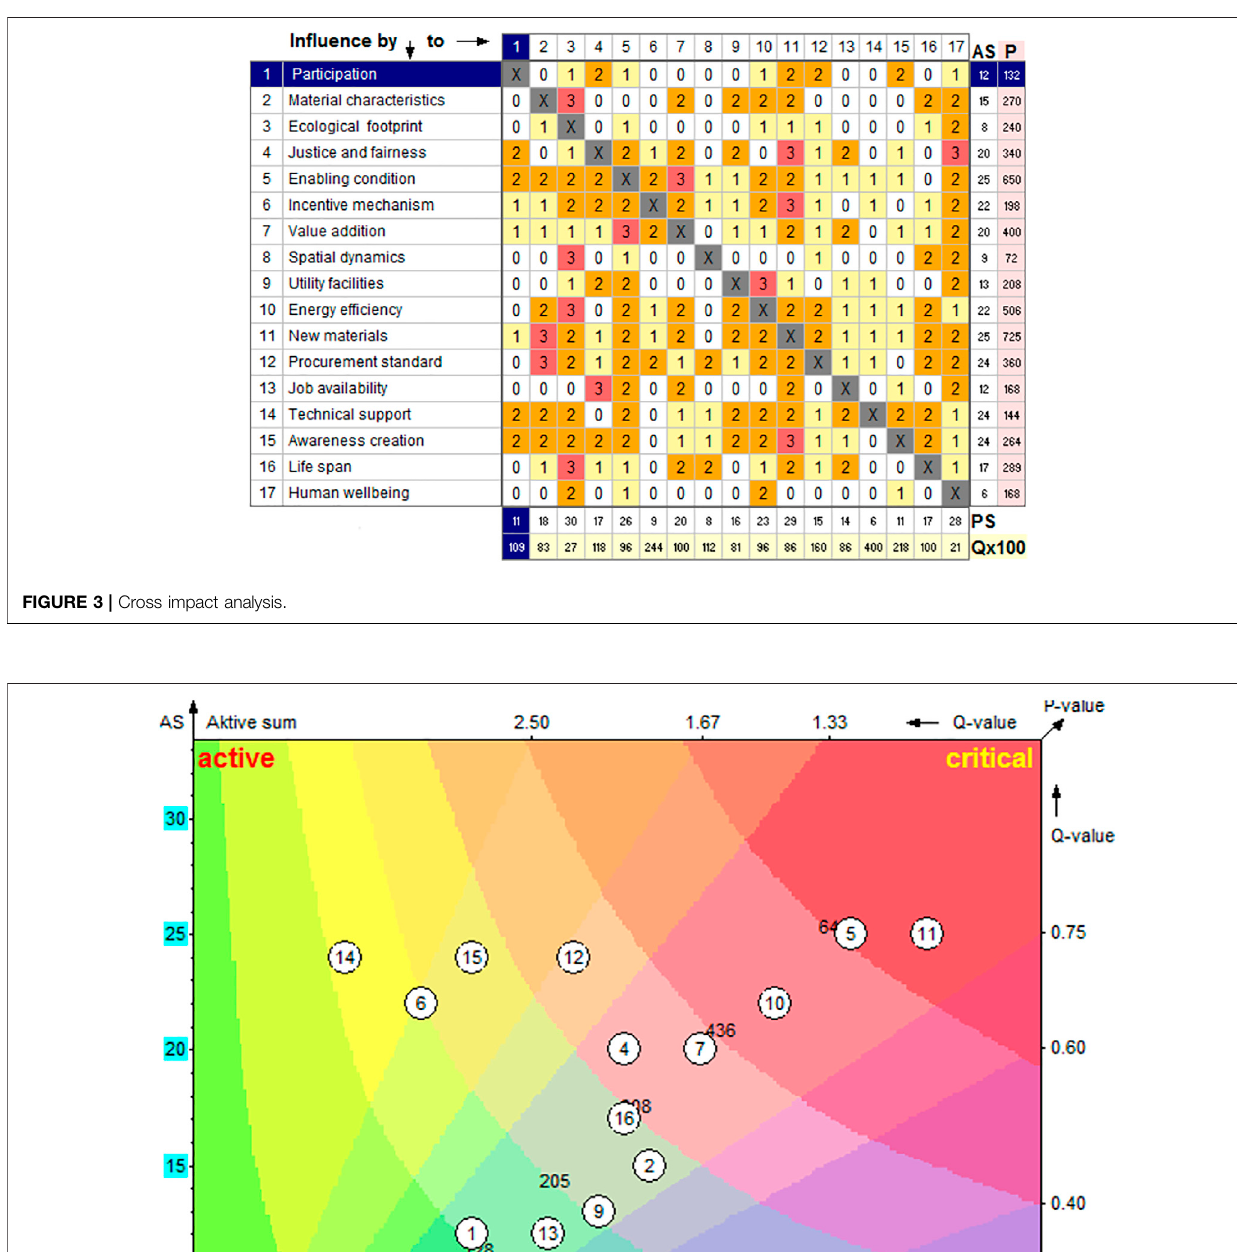
Frontiers in Built Environment |